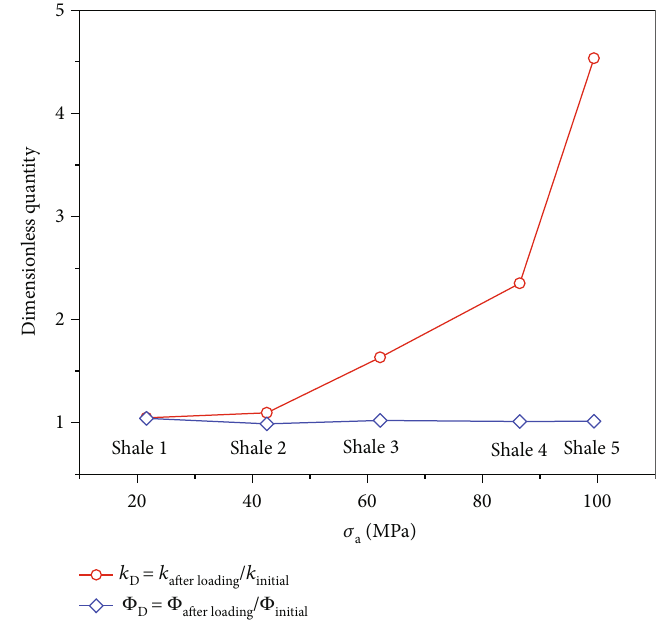
Figure 10: The dimensionless permeability and porosity under